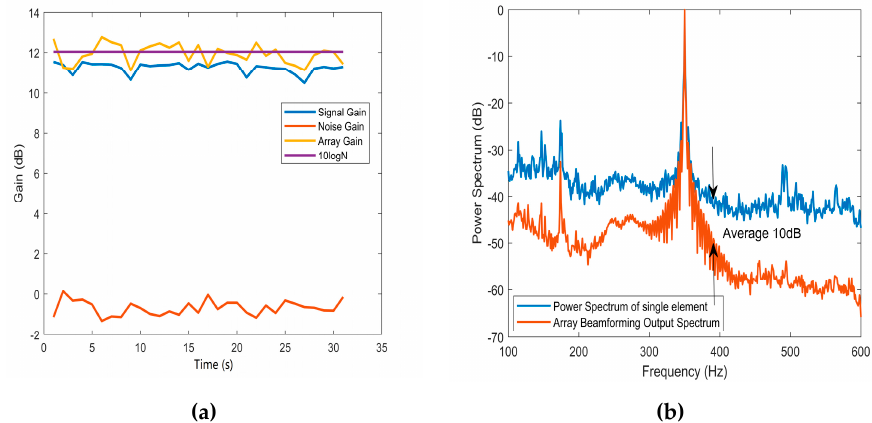
Figure 15. Calculation results in the direct-arrival zone ( a ) signal gain, noise gain, and array gain; ( b ) power spectrum of single element and array beamforming output power spectrum.